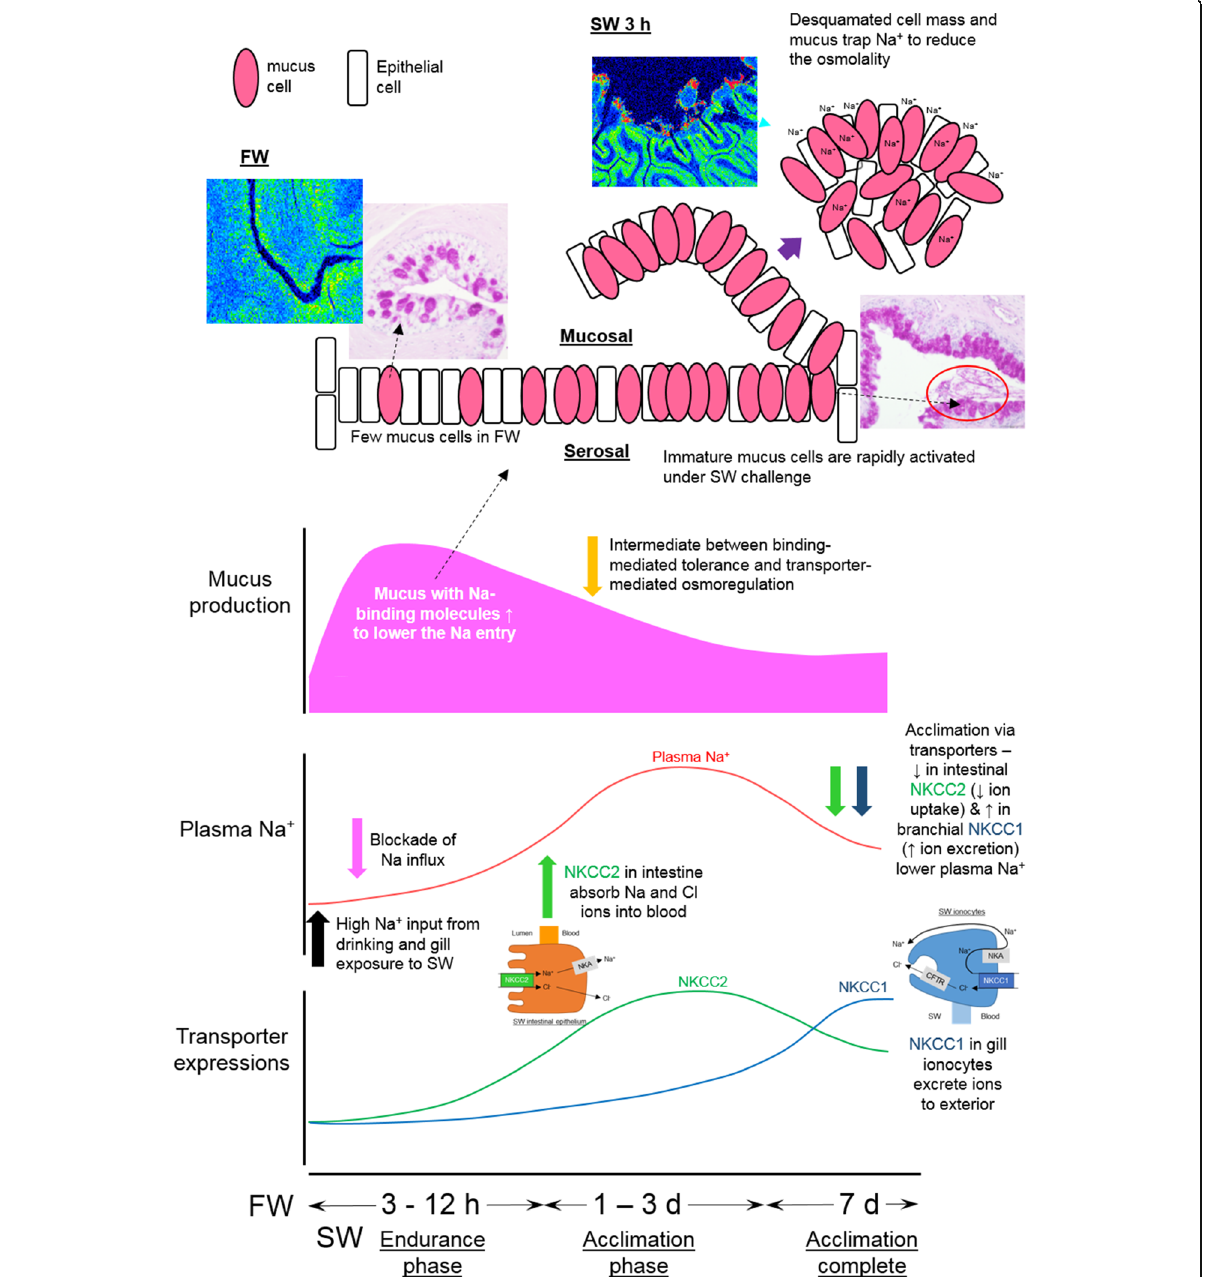
Fig. 10 Schematic model of Na trapping by specific binding molecules in mucus and sequential events that leads to the delay biphasic change in plasma Na + in eels following FW to SW transfer. Mucus cells were activated after SW transfer and produced mucus containing Na-binding molecules rapidly, which trapped ionic Na + to reduce the osmotic potential of imbibed SW. The Na-binding and ion absorption/excretion mechanisms were recruited at different time points after SW transfer, and interplayed each other to resolve the salt stress in a specific order, resulting in the signature delay of plasma Na + changes. The circle region indicates desquamated cells containing high bound Na content revealed by EPMA